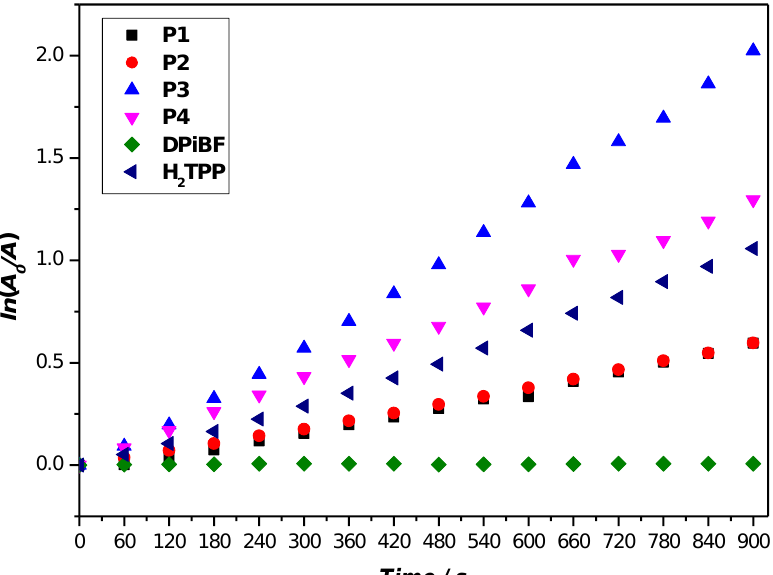
Figure 7. Time-dependent photodecomposition of DPiBF (50 µ M) photosensitized by P1 , P2 , P3 and P4 in DMF upon irradiation with red light (640 ± 20 nm) with or without PS (0.5 µ M). H 2 TPP was used as the reference.